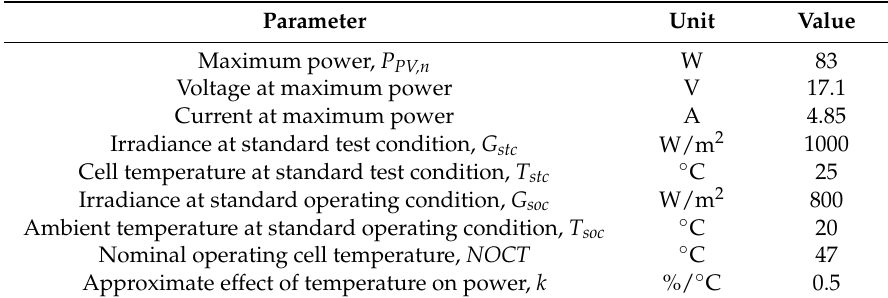
Table 2. MSX-83 PV module characteristics